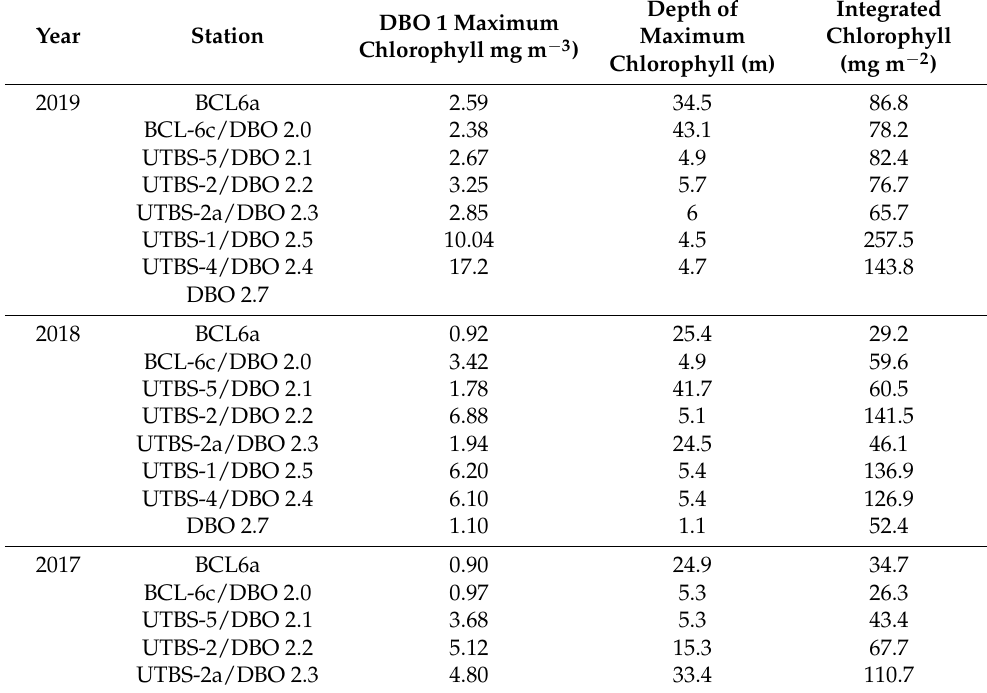
Table 2. DBO 2 Stations, south of St. Lawrence Island, 20-year time series for